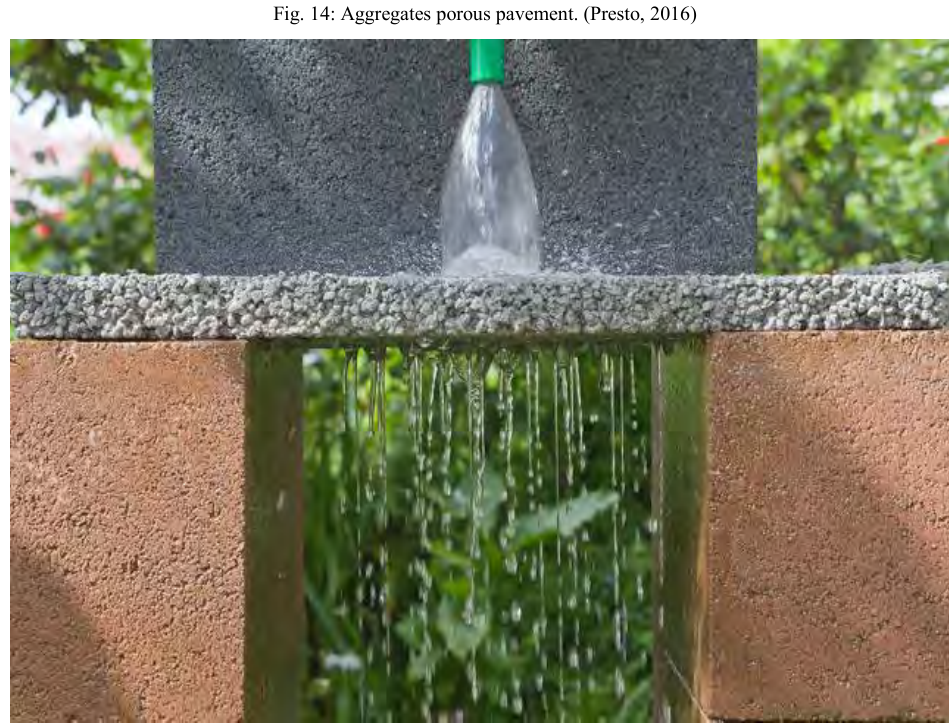
Fig. 14: Aggregates porous pavement. (Presto, 2016)